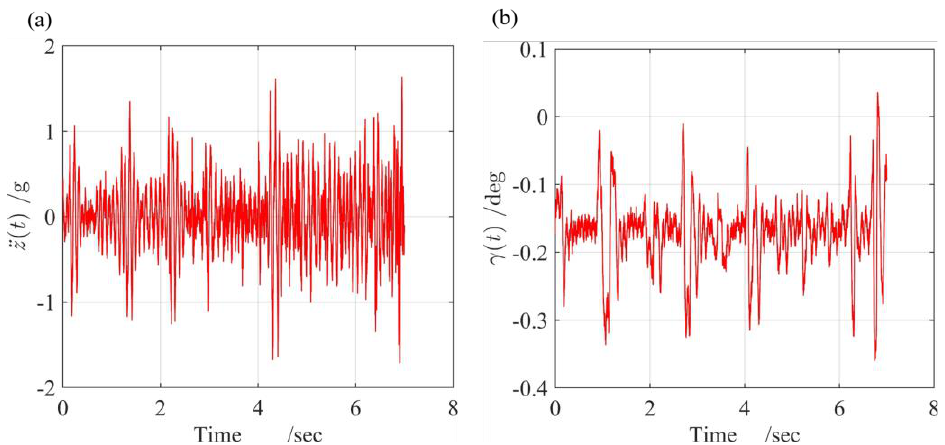
Figure 2. Experimental running results when v = 13.7 mps: ( a ) vertical displacement acceleration .. z ( t ) ; ( b ) pitch angle γ ( t ) .